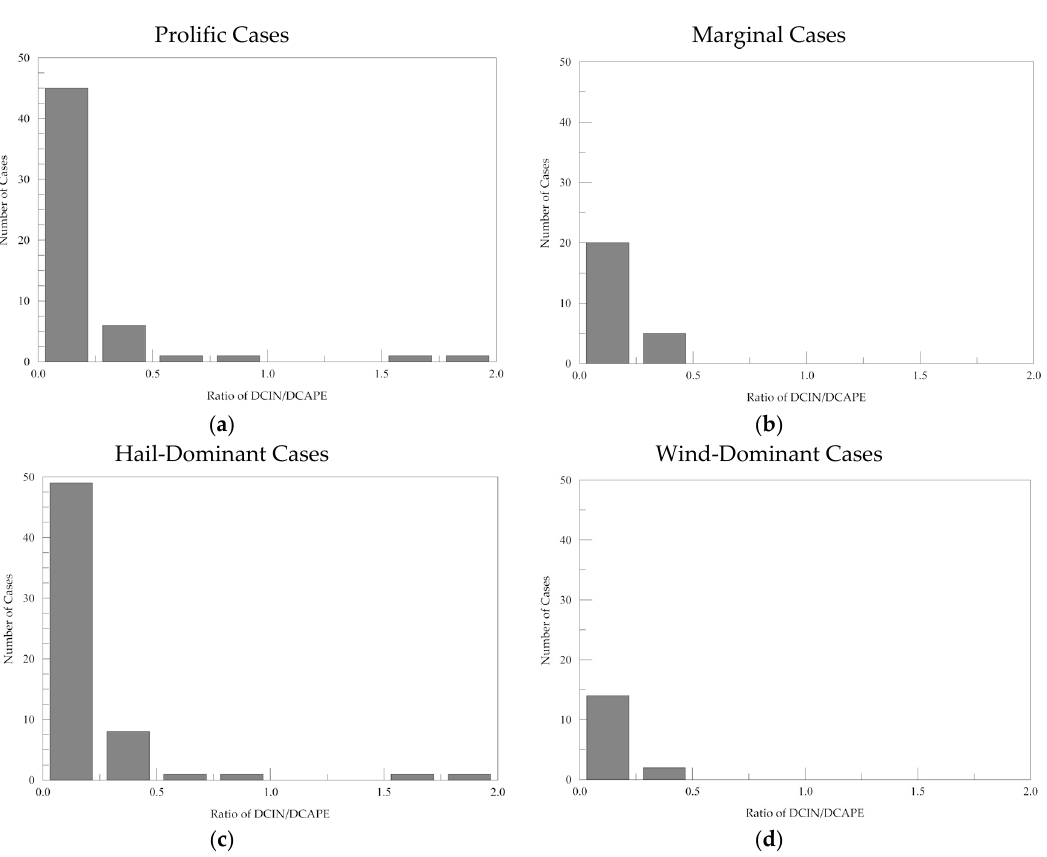
Figure 3. Histograms of | DCIN |/| DCAPE | ratio based on initial report of severe weather: ( a ) Prolific cases ( b ) Marginal Cases, ( c ) Hail-Dominant cases, ( d ) Wind-Dominant cases.